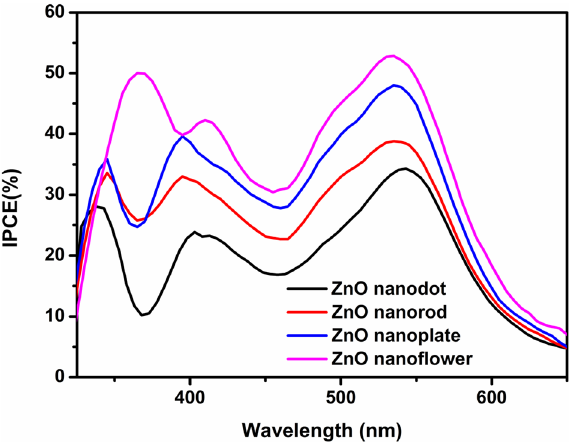
Figure 10. IPCE spectra of DSSCs based on ZnO nanostructures as photoanode.